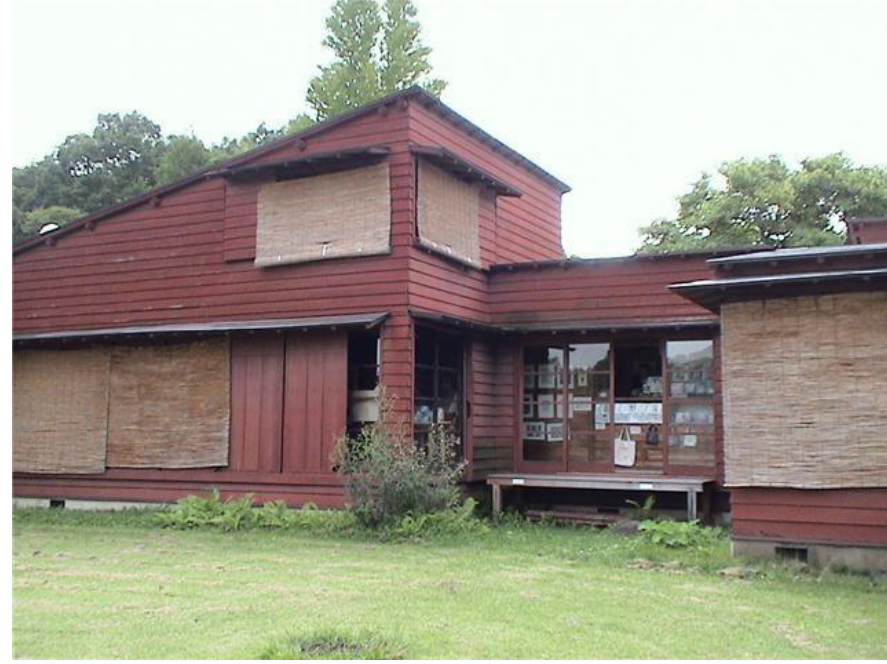
Figure 9. Karuizawa summer house — lightness and transparency .